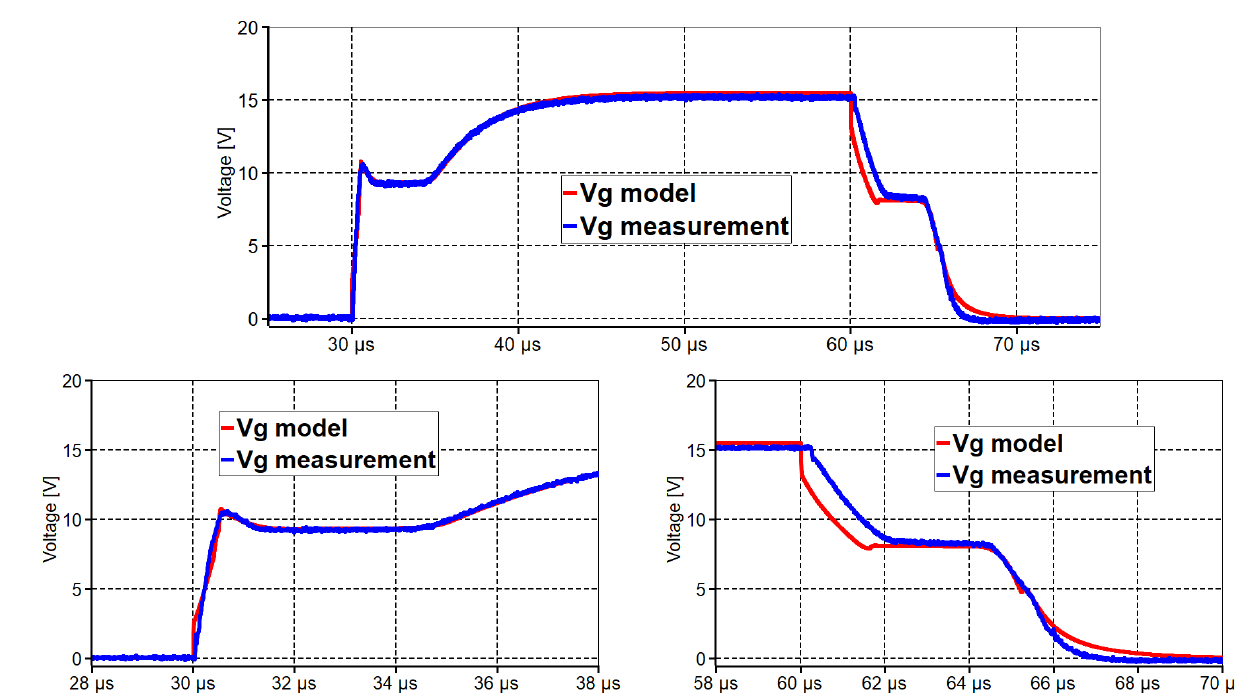
Figure 10. Gate voltage for 15 V input pulse.